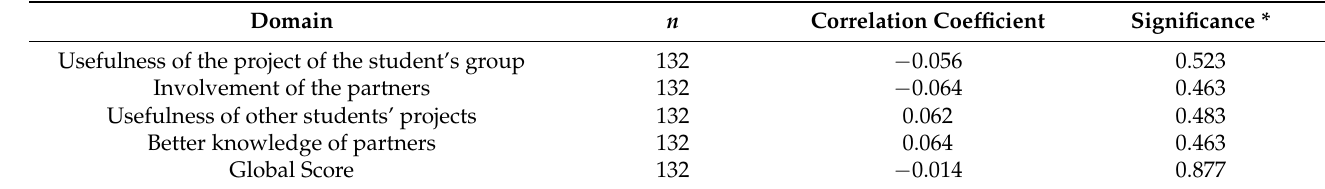
Table 10. Score of the domains, regarding